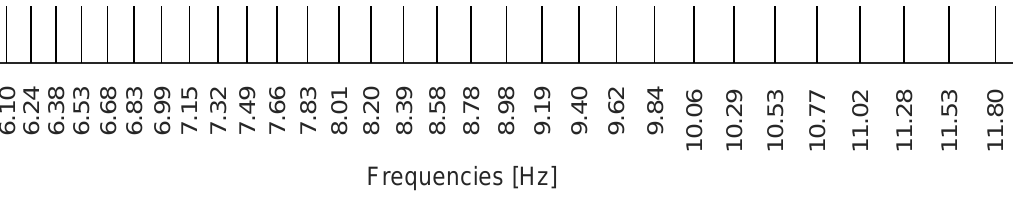
Figure 2. A logarithmically spaced set of frequencies used for the steady-state visual evoked potentials based application ( SSVEP speller ). Frequencies were implemented on the basis of the frequency approximation